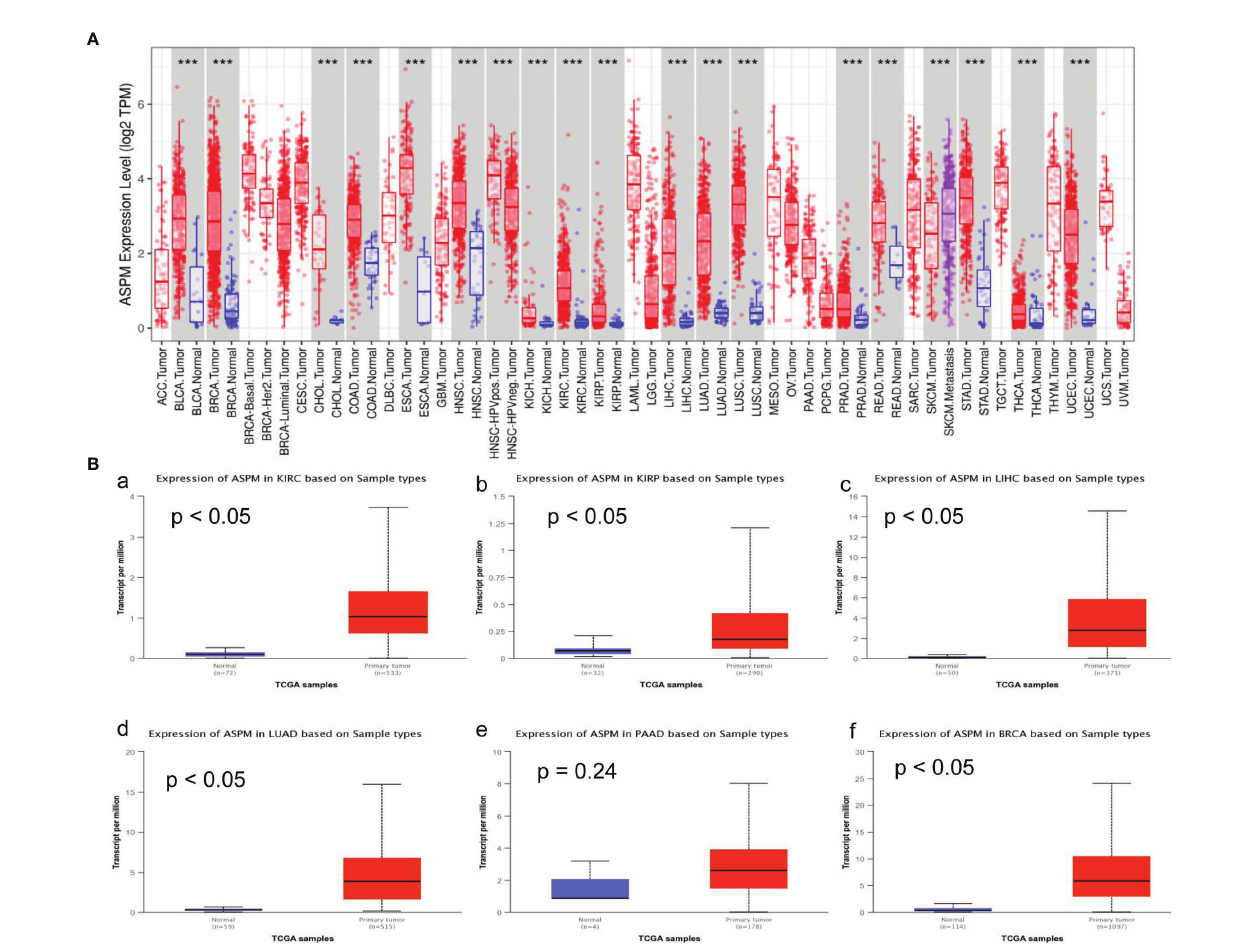
FIGURE 1 | ASPM mRNA expression levels in various types of cancer. (A) The expression levels of ASPM in various types of cancer tissues and their corresponding normal tissues were analyzed using the Tumor Immune Estimation Resource (TIMER) database. It includes 10,897 samples for 32 cancer types from The